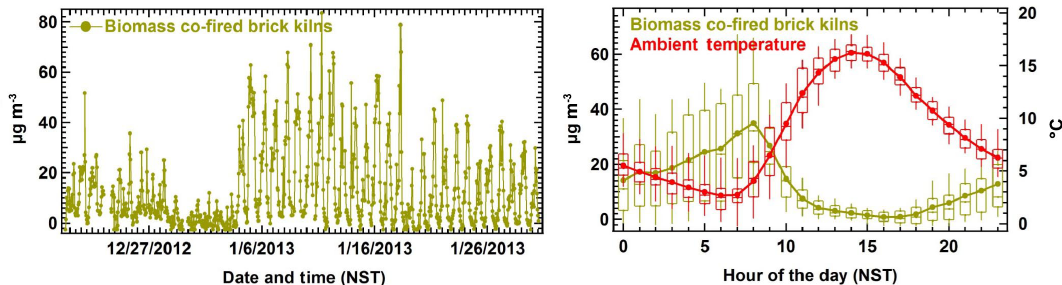
Figure 7. Time series and diel box and whisker plot for Factor 4 (biomass co-fired brick kilns).